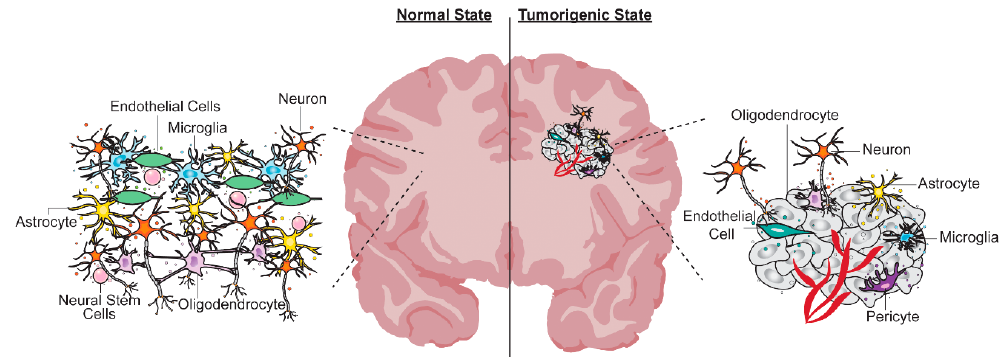
Figure 2. Schematic of EV-mediated cell–cell interactions in the healthy and tumorigenic brain. Normal brain (left panel) and brain tumor microenvironment (right panel). In a healthy state, EVs released by normal neural cells (neural stem cells (NSCs), neurons, oligodendrocytes, astrocytes), inflammatory cells (microglia) and endothelial cells promote cell–cell interactions, which contribute toward the formation of an intricate neural network (left side; magnified panel). In a tumorigenic state, the tumor microenvironment is a complex ecosystem of tumor cells intricately knit together with ‘normal’ brain cells. Tumor–tumor homotypic interactions and tumor–‘normal’ cell heterotypic interactions can be mediated via EVs secreted in the tumor microenvironment. Cell-specific EVs are represented as small spheres with the same color as the cell that releases